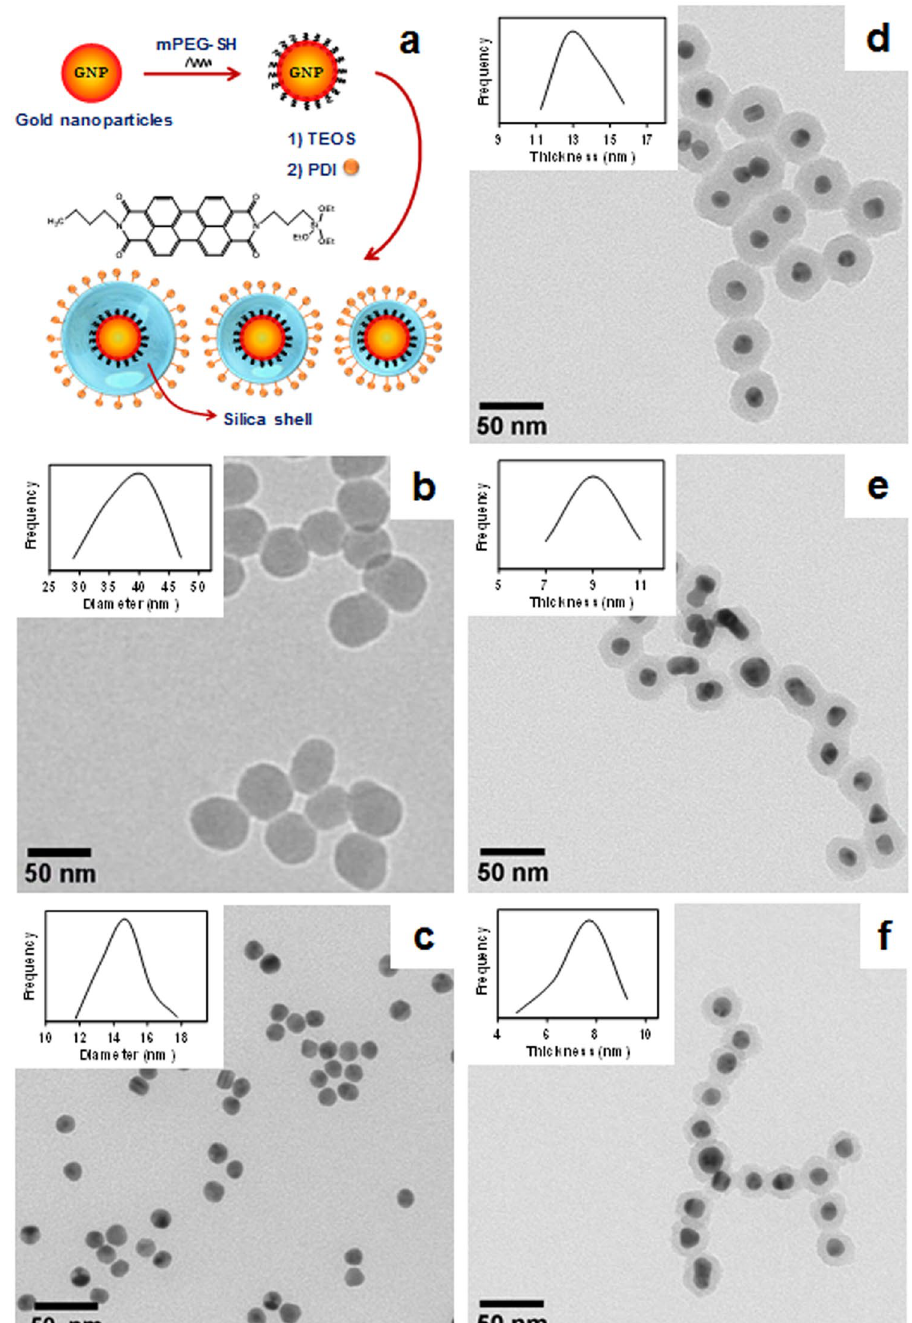
Figure 1. ( a ) GNPs were stabilized using a thiol-terminated poly(ethylene glycol), mPEG-SH, in order to transfer the GNPs to ethanol and grow a silica shell of controlled thickness. The surface of the core-shell nanoparticles was subsequently modified with a triethoxysilyl-modified perylene diimide (PDI). TEM images of SiNPs ( b ), GNPs ( c ), GNPSi13 ( d ), GNPSi9 ( e ), and GNPSi7 ( f ) show that the gold core is encapsulated in silica for all core-shell nanoparticles. The insets in ( b , c ) show the particle size distribution curve, and the insets in ( d – f ) show the silica thickness distribution